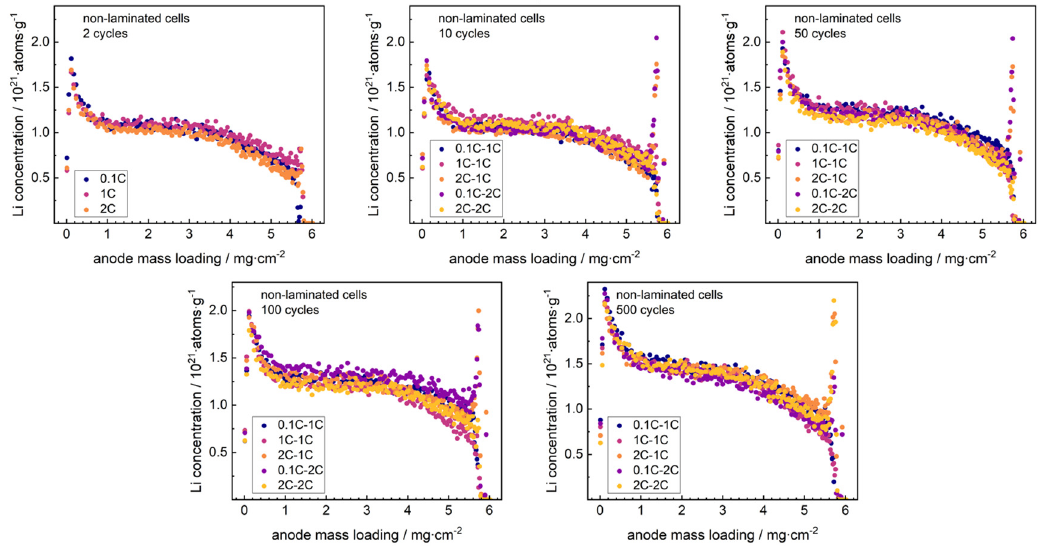
Figure 2. Change of lithium depth profiles of delithiated graphite anodes along cycling, extracted from non-laminated cells along cycling (500 cycles total) after a varied formation rate (2 initial cycles).